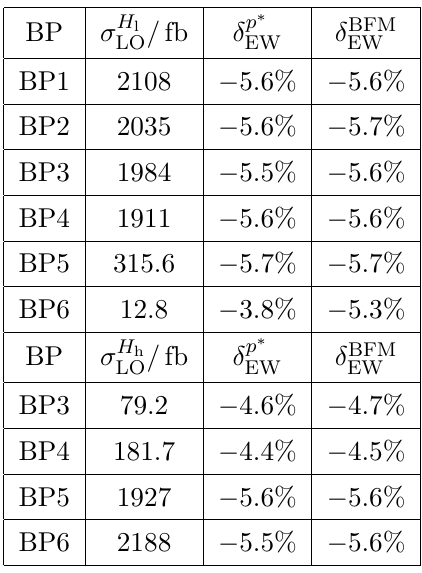
Table 14. Relative NLO corrections (cid:14) EW to Higgs-boson production in VBF pp ! H l =H h jj in the HSESM. The light Higgs production is in the upper table, indicated as (cid:27) H l whereas the heavy one LO is in the lower table, indicated as (cid:27) H h . LO (table 10) no predictions in the MS scheme are presented as these scale uncertainties